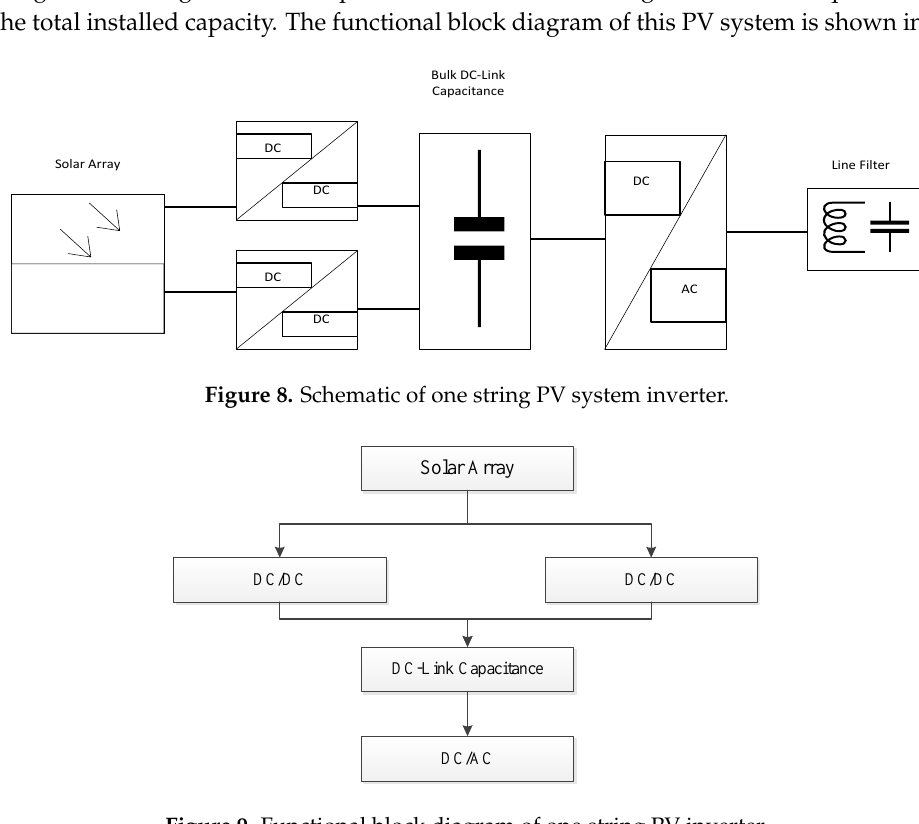
Figure 9. Functional block diagram of one string PV inverter.